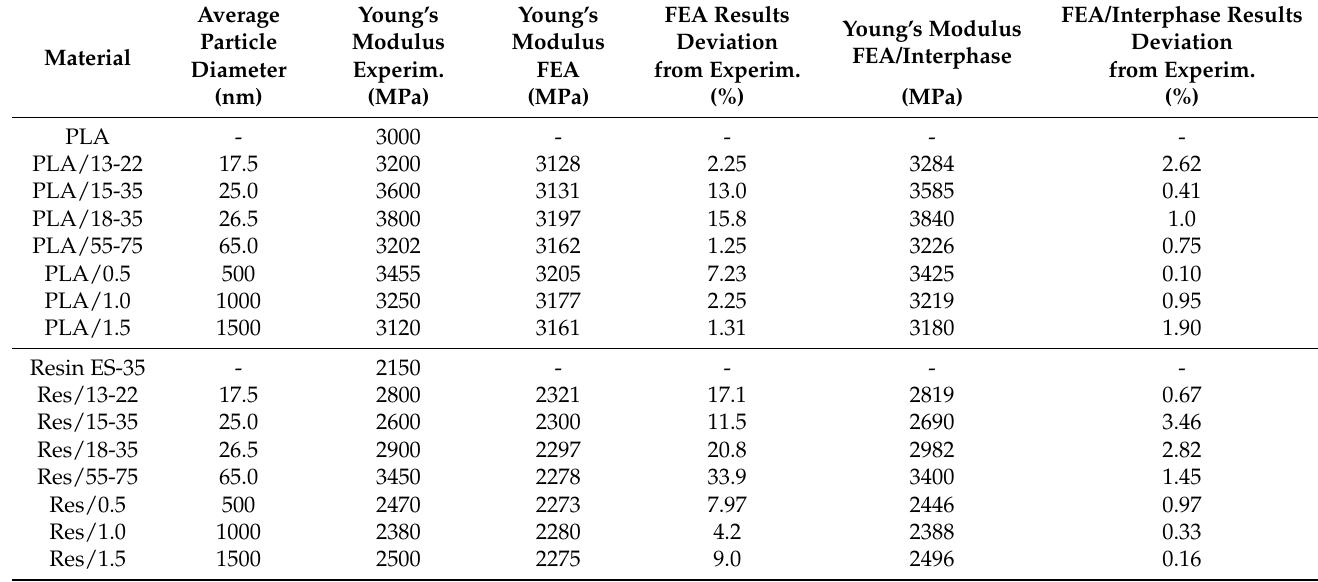
Table 4. Finite element analysis